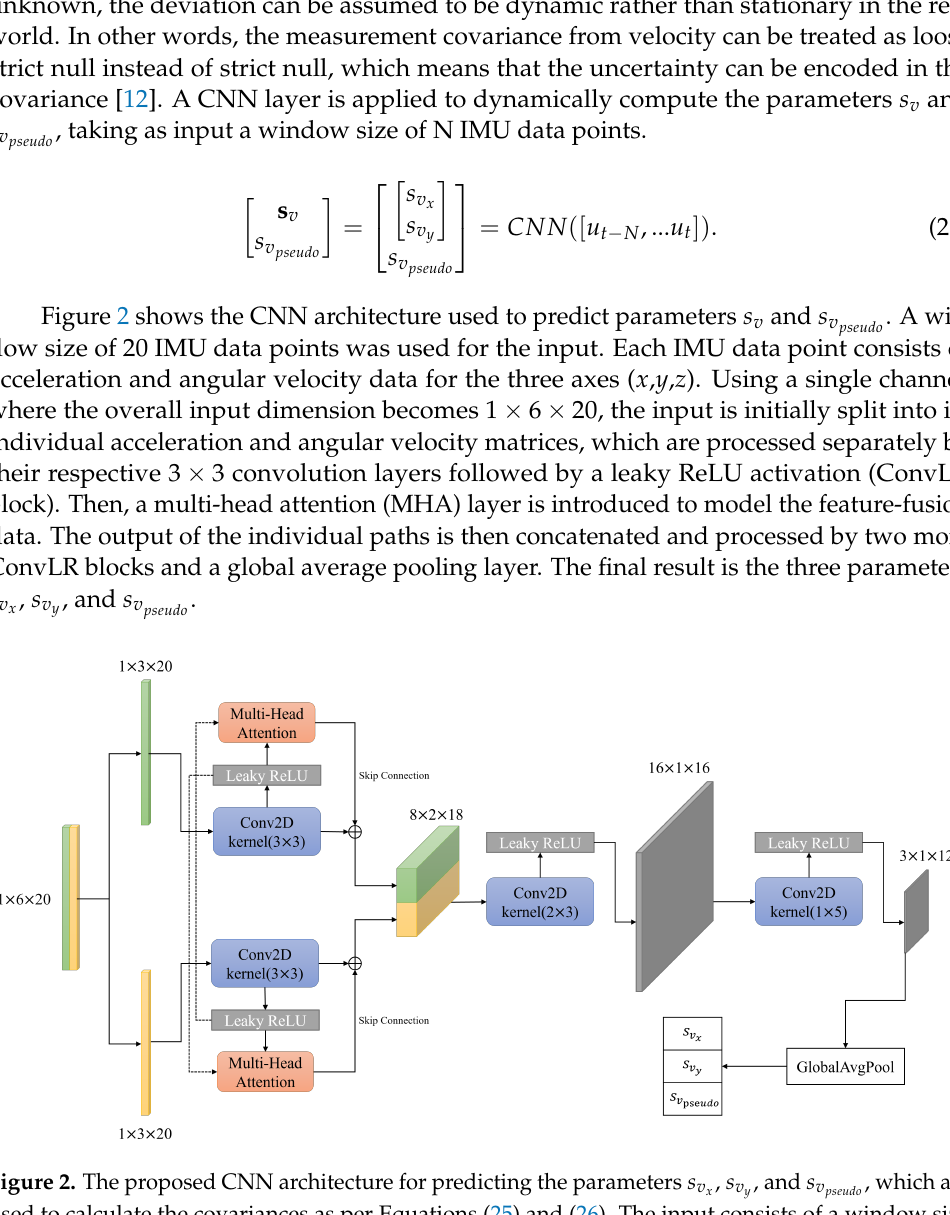
, s v , and s v , which are x y pseudo